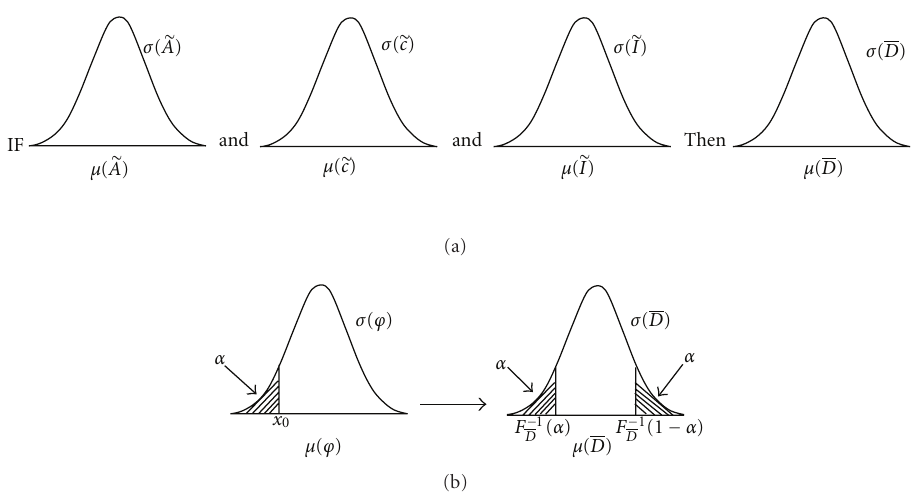
Figure 2: (a) Representation of a probabilistic rule base (PRB) to infer decision variable D ; (b) the CCI method.